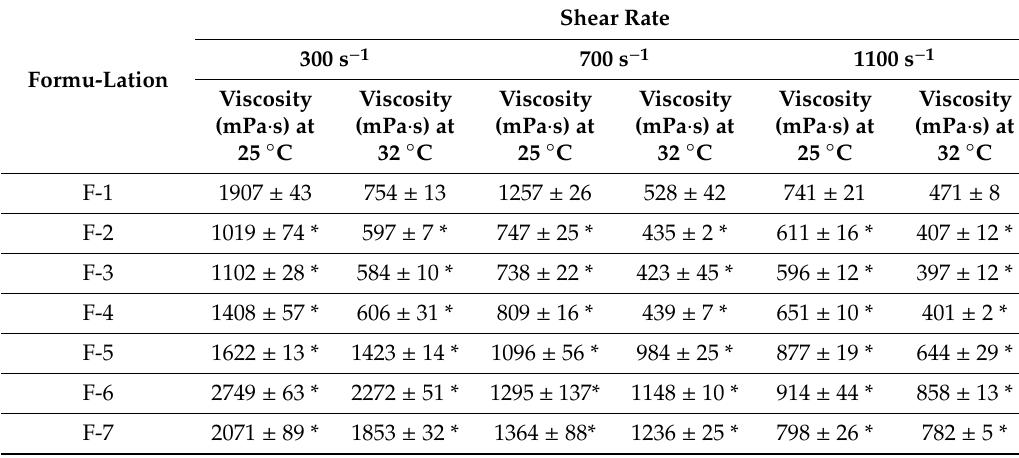
Table 3. Viscosity parameters of formulations determined at 25 and 32 ◦ C at three selected shear rates. Shear Rate 300 s − 1 700 s − 1 1100 s − 1 Formu-Lation Viscosity Viscosity (mPa · s) at 25 ◦ C